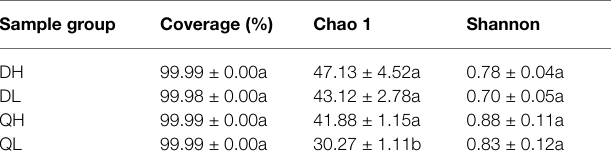
TABLE 2 | Root fungal abundance and diversity in peach rootstocks under HP and LP conditions. Sample group